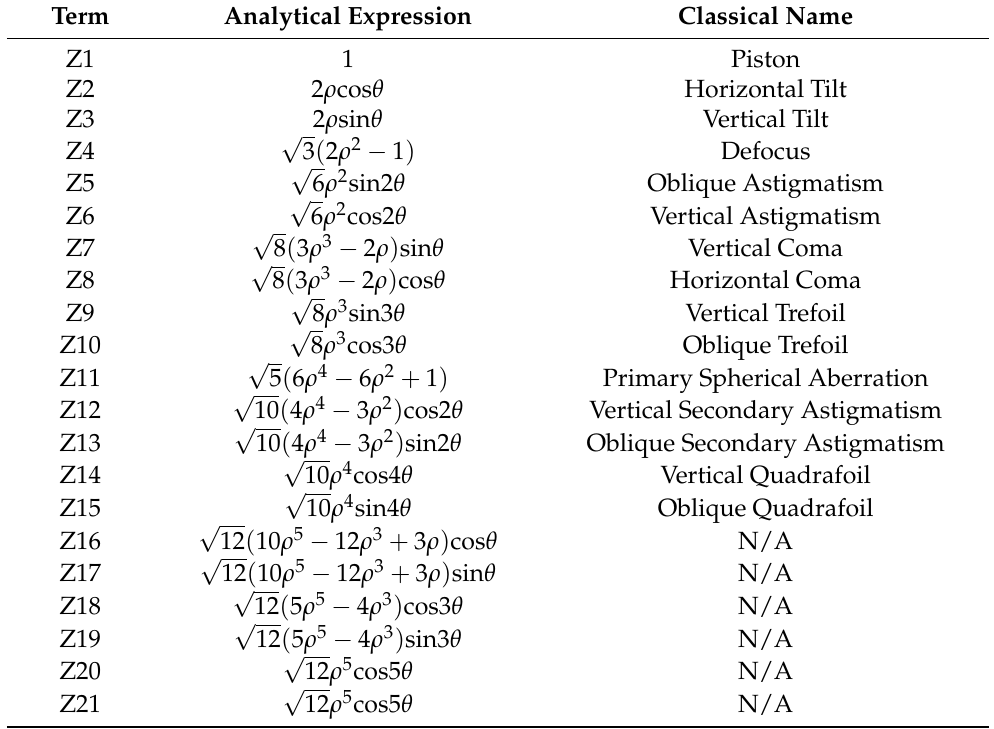
Table A1. Analytical expressions of the low-order Zernike modes (in Noll’s